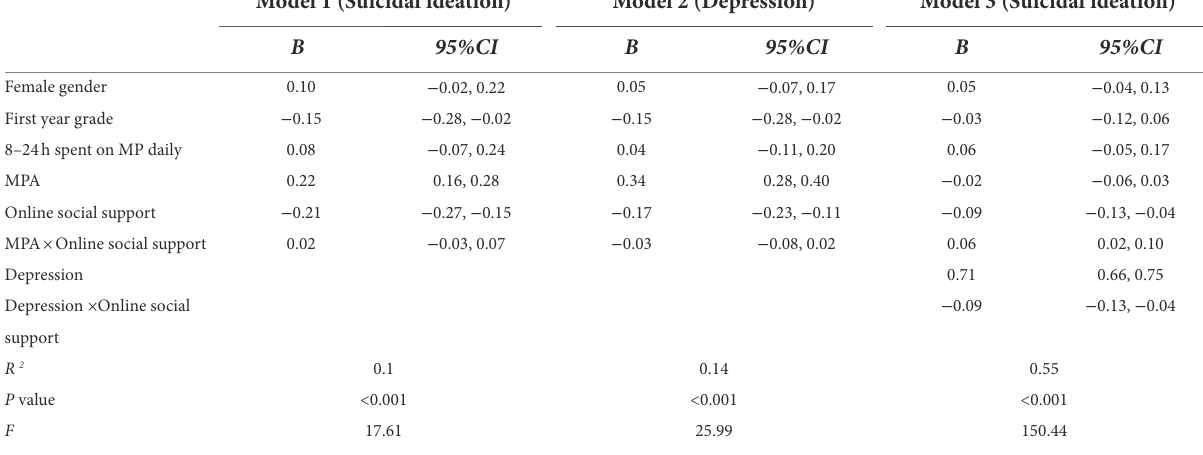
TABLE 4 Moderated mediation effect analyses for online social support.